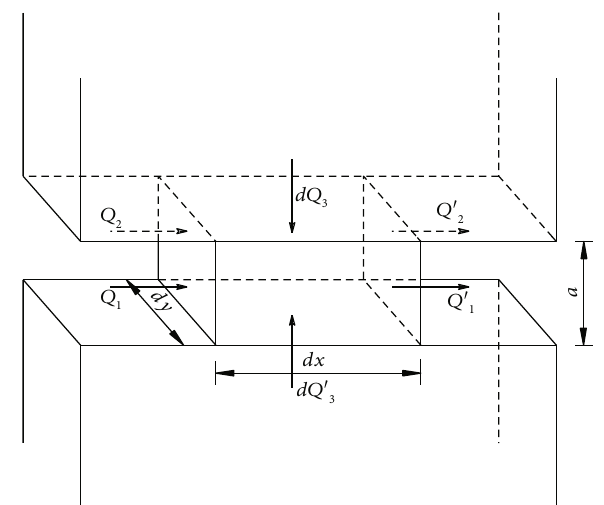
Figure 1: Heat equilibrium of fl uid in fi ssure for a calculation